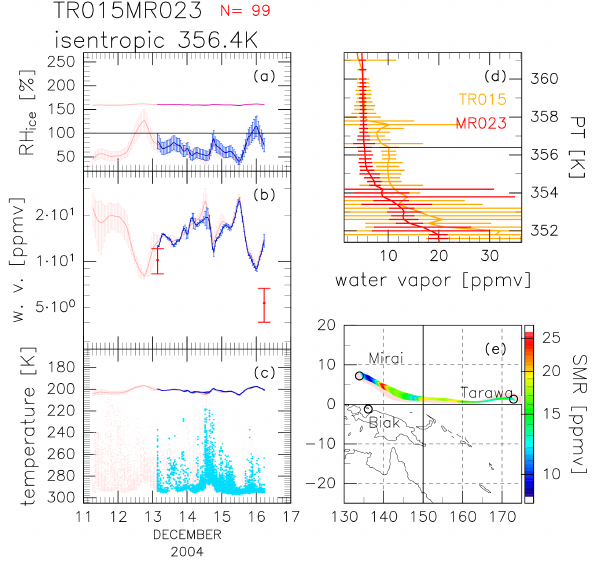
Fig. 6. As for Fig. 5 but for the match that advected from Tarawa (03:48UT, 13 December 2004) to Mirai (05:17UT on 16 December 2004) at the 356.4K potential temperature surface with an advec- tion time of about 3